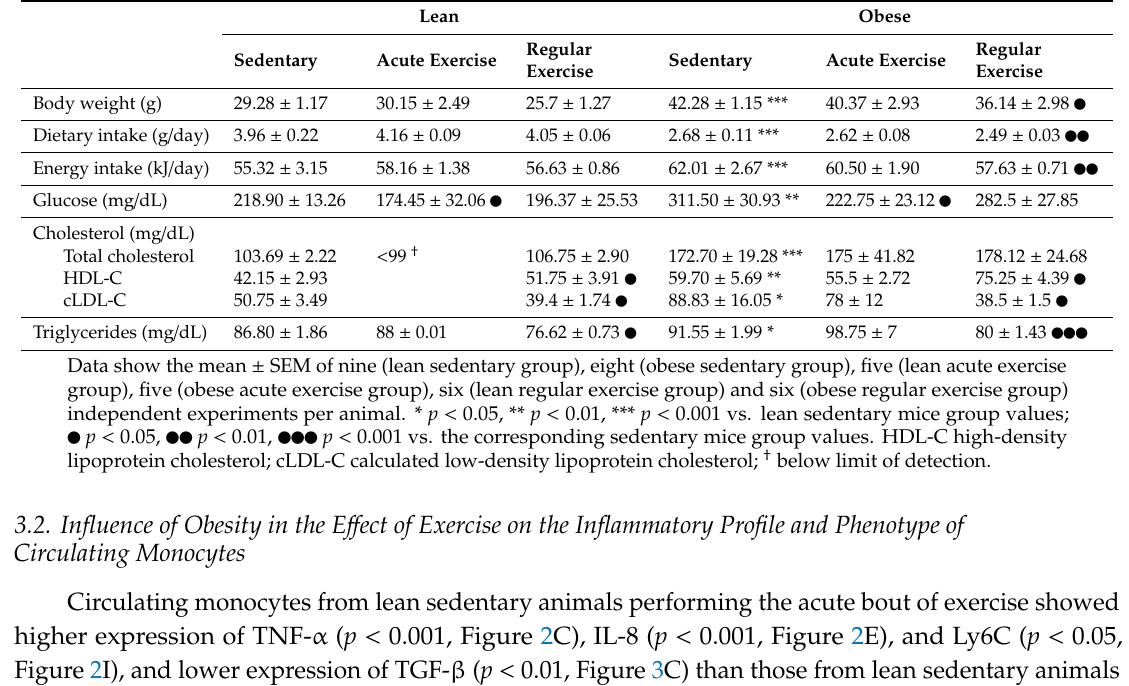
Table 1. Body weight, dietary and energy intake, and metabolic parameters in lean and obese mice, with or without acute or regular